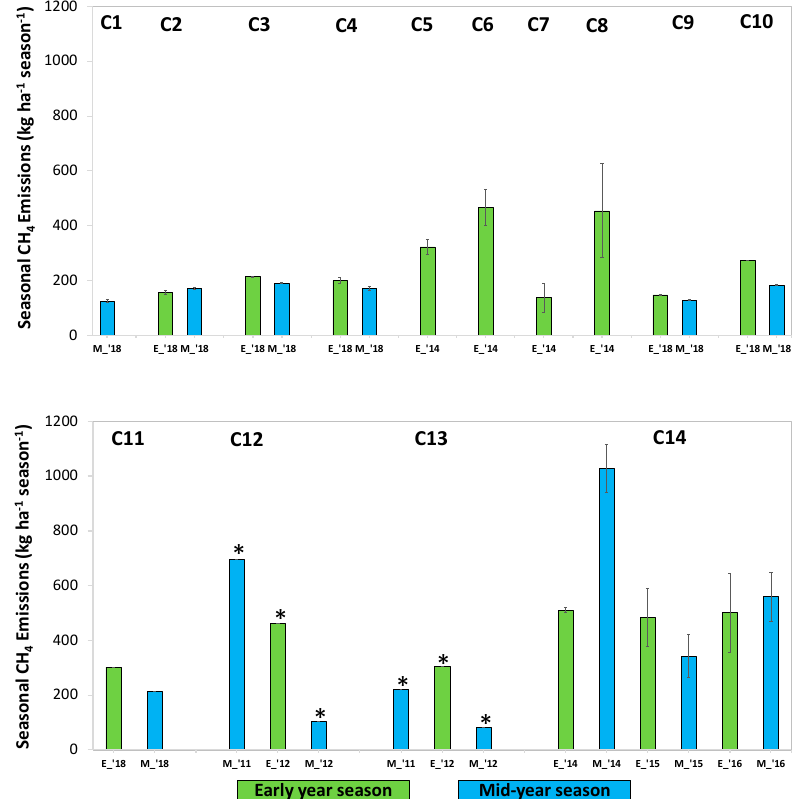
Figure 5. Seasonal emission rates of field measurements in Central Vietnam; standard errors among three replicates shown as error bars or marked by asterisks if not available. Crops are shown in sequential order which does not always correspond to the chronological order shown in Figure 2. Table 2. Field measurements of daily methane emission rates and cultivation period in Central Vietnam. For site locations, refer to Figure 2; Cult. per.—cultivation period; nd—not determined; ↔ —no rice crop grown; error—standard